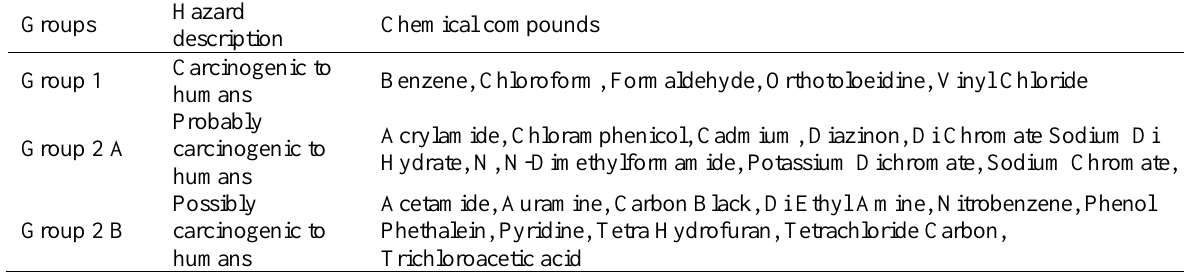
Table 2. Examples of chemicals in different groups of the IARC classification Groups